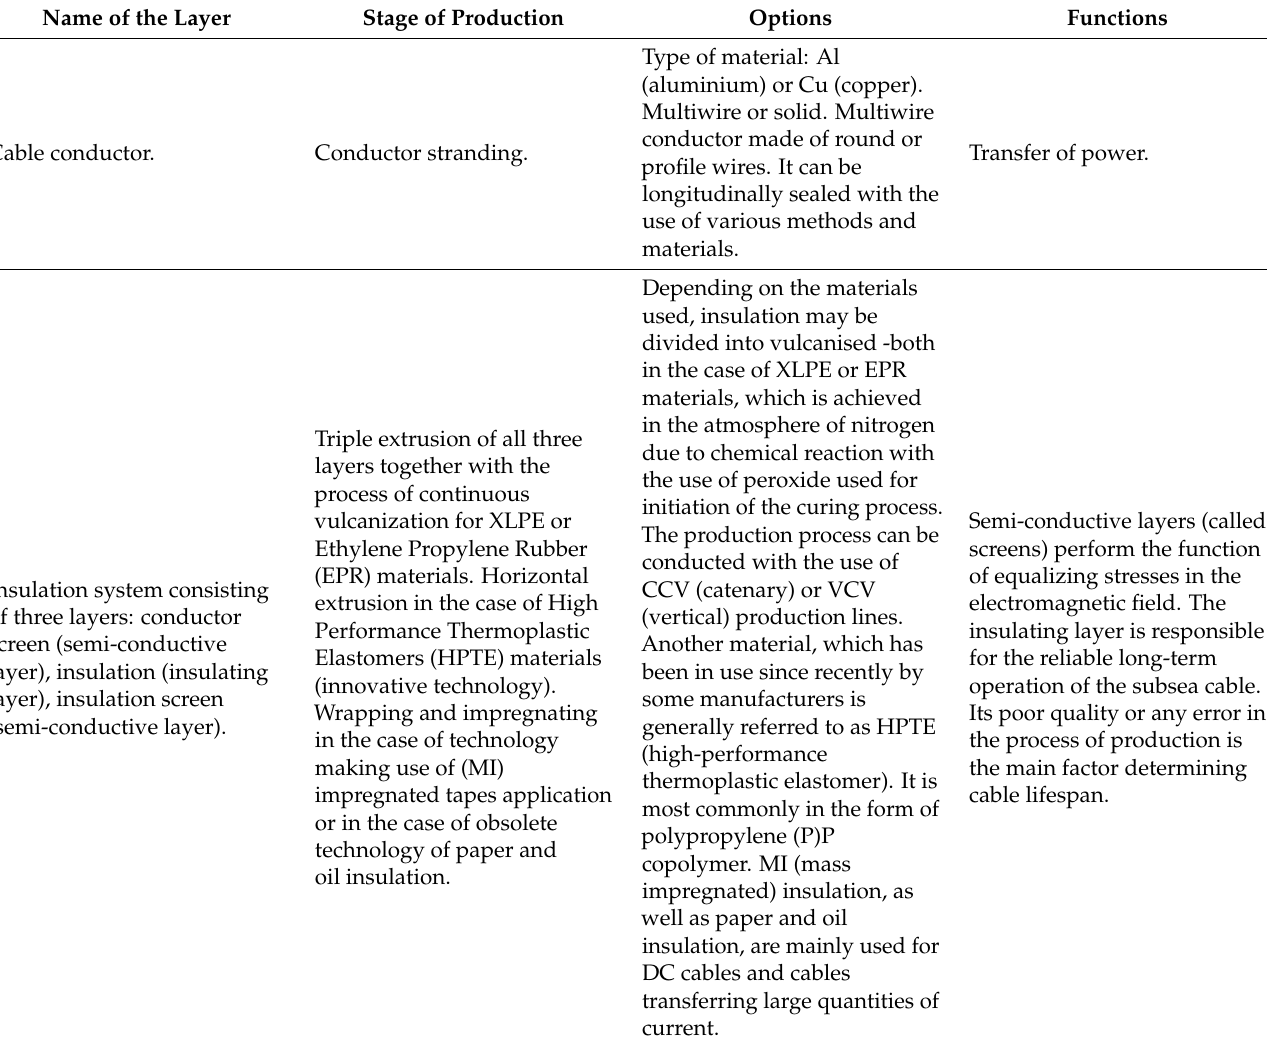
Table 1. Basic components of submarine cable’s construction, common for all types of cables. Name of the Layer Stage of Production Options Functions